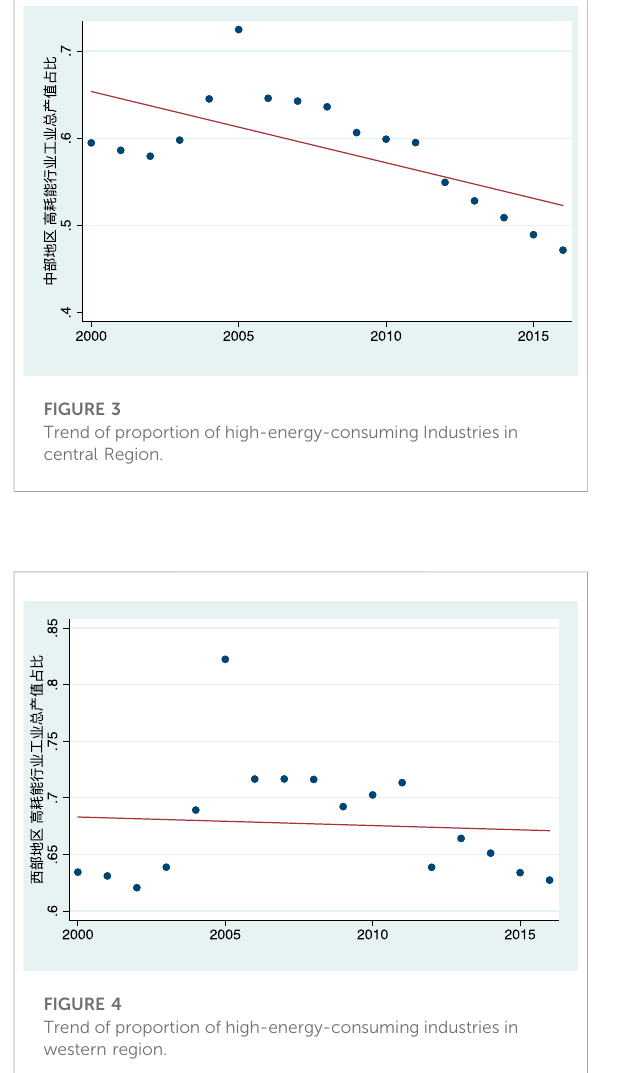
FIGURE 4 Trend of proportion of high-energy-consuming industries in western region.